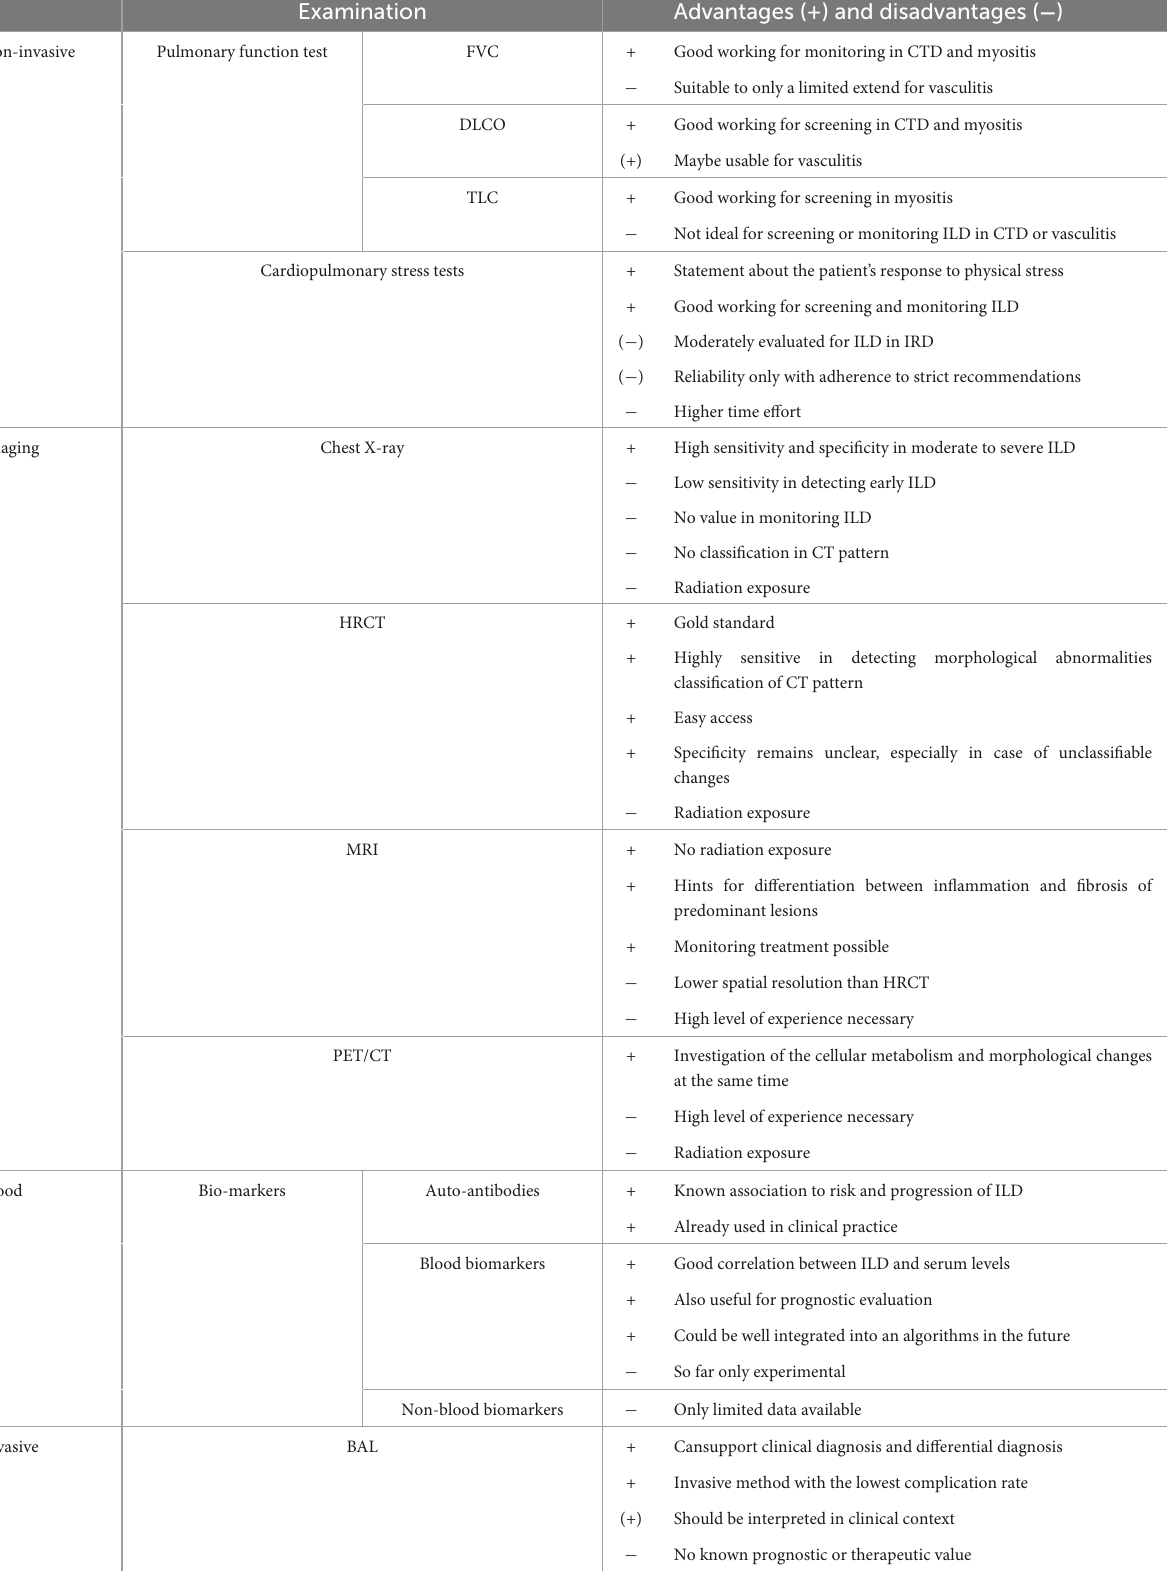
Examination Advantages (+) and disadvantages ( − )